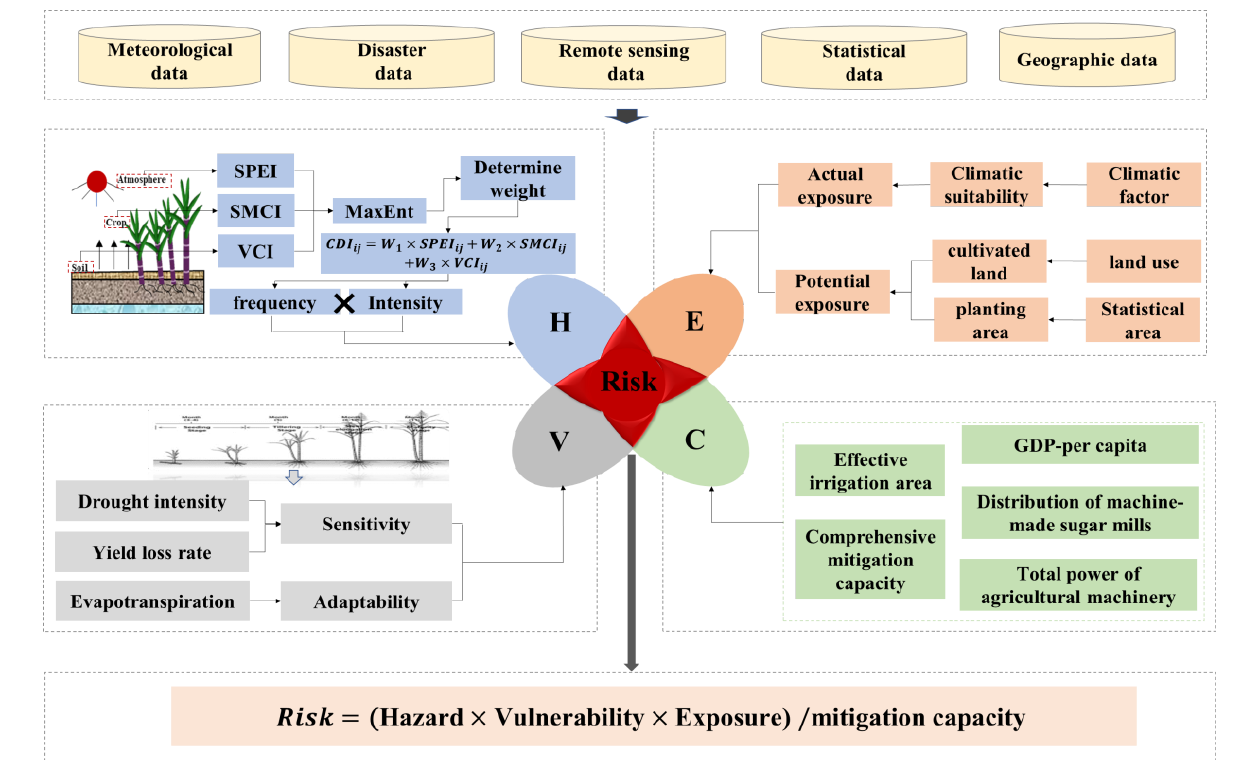
Figure 2. Schematic representation of assessment process of drought disaster risk of sugarcane in Guangxi Province .